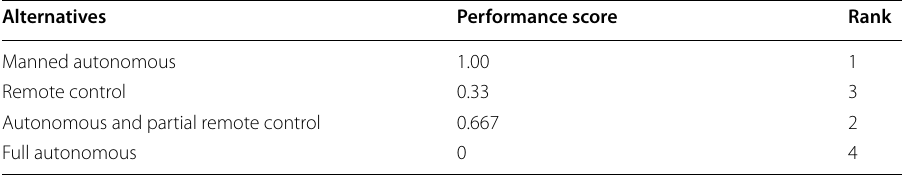
Table 9 Ranking of alternatives